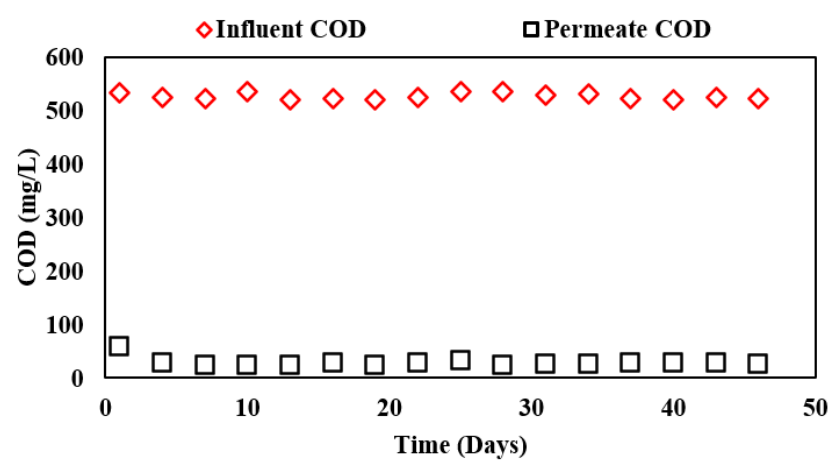
Figure 4. Influent and effluent COD concentrations in ABR-AF coupled membrane system during Phase III.